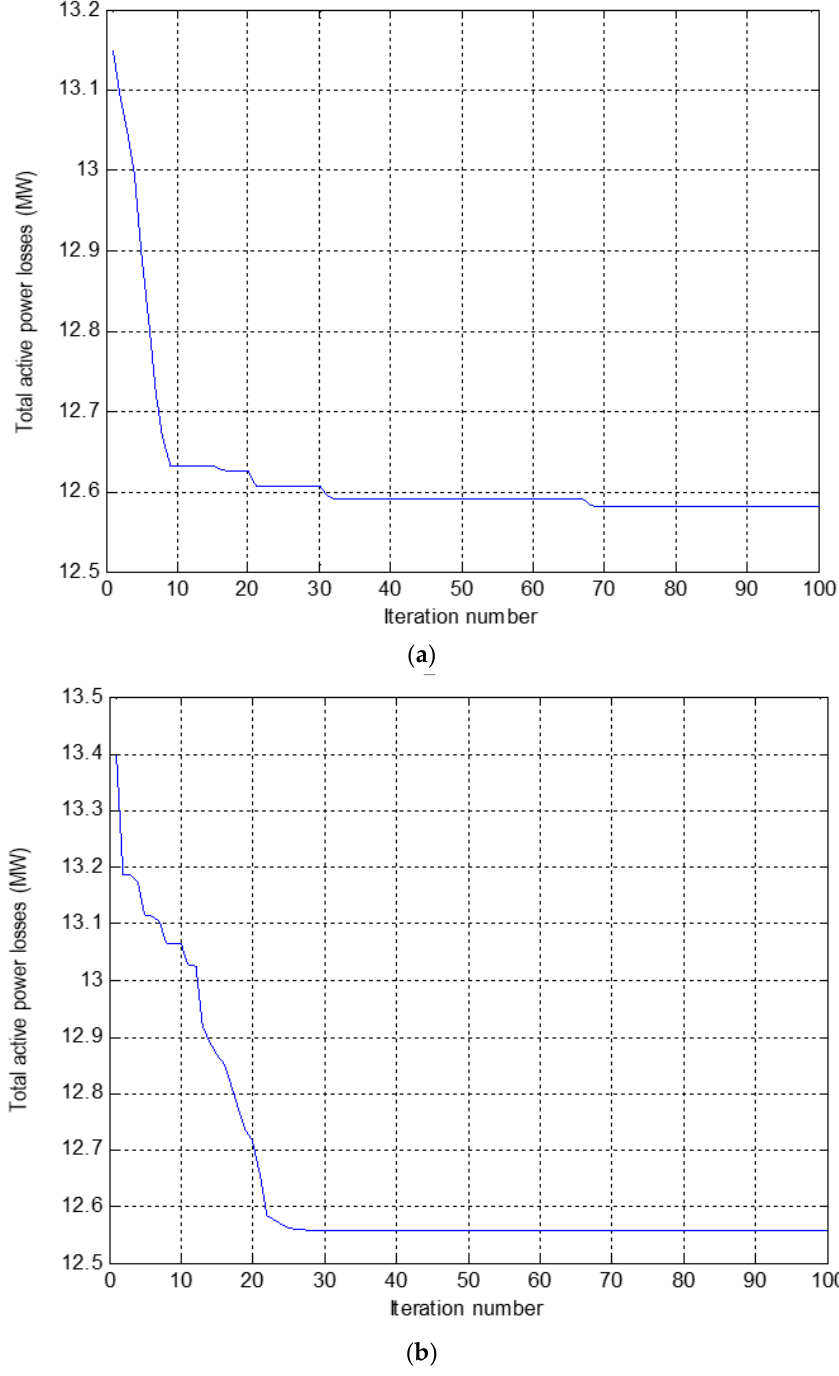
Figure 3. Number of iterations by using ( a ) the PSO-OPF method and ( b ) the IPSO-OPF method.